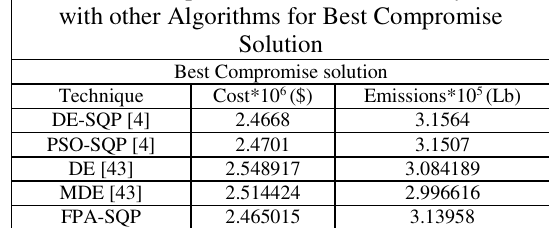
Table 8: Comparison of Ten-Unit Test